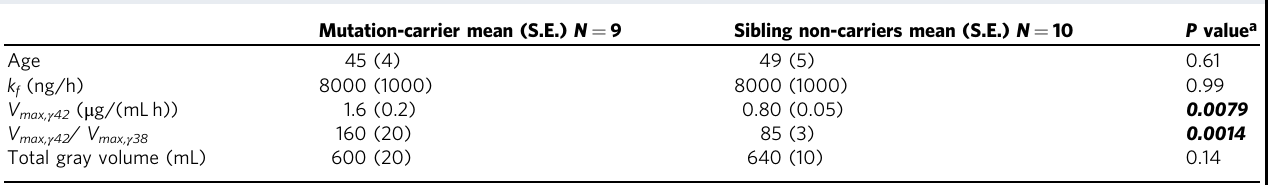
blood – brain barrier.